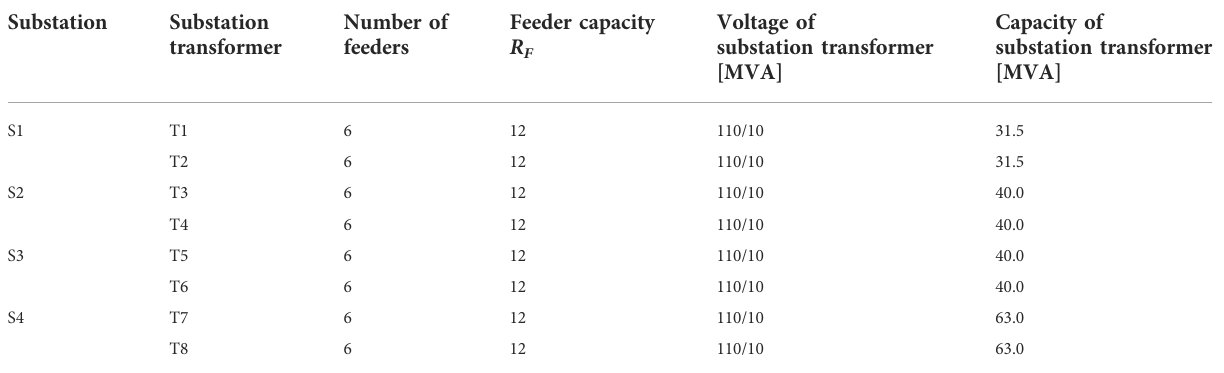
TABLE 2 Basic parameters of case